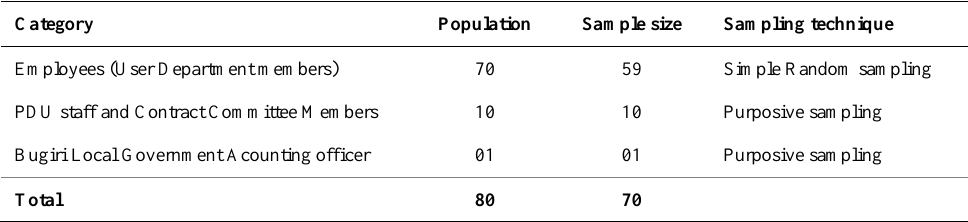
Table 1. Population, Sample size and Sampling